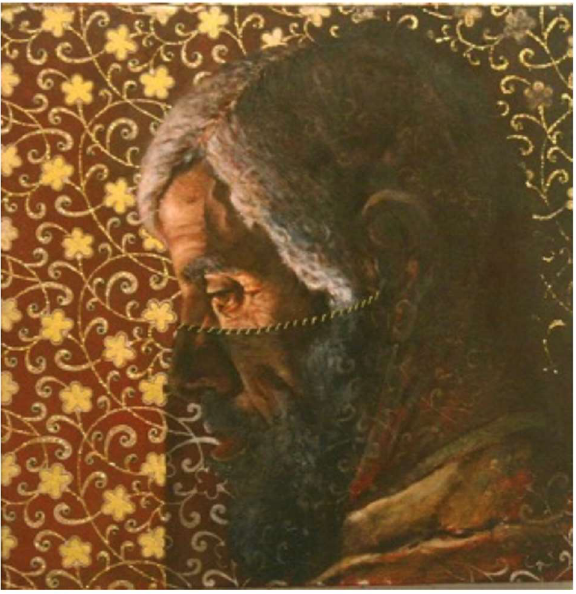
Figure 9. Fatma Abu-Rumi, Father, 2007, oil and crystal stones on canvas, 30 × 30 cm. A sharp and direct conflict is drawn in the work My Father and Me , (2005) (Figure 10), between she who directs her gaze but is covered from head to toe and positioned partially in darkness, and the figure of the father adorned with a halo of stones. His bare feet are resting on a floor decorated with a geometric star pattern. The geometric ornament in the painting is a symbol of order; it is an expression of a centuries-old tradition of aniconic Muslim artwork that corresponds to a theological and social worldview in Muslim culture. The decorated geometric floor that maps the space marks the definition of roles, the division between forward and back, and the movement from the front plane to the back plane in the painting; but it also marks thousands of years of cultural, social, and gender traditions, in which it is the man who sets the tone, organizes the living space, and